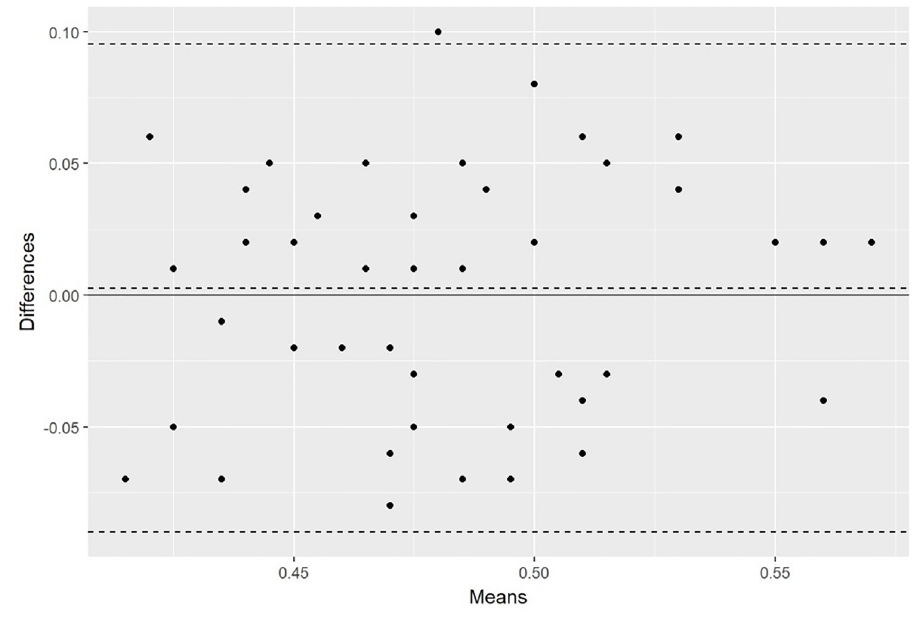
Fig 3. Blan-Altman plot showing the coefficient repeatability of RI measurements in examined